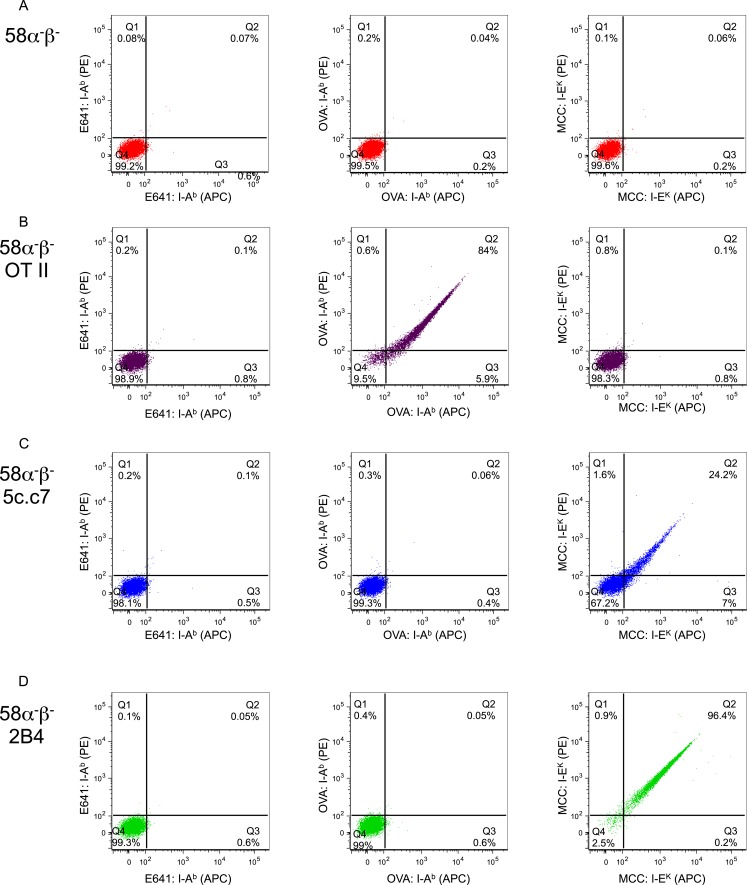
Tetramer validation on T-cell hybridomas.Dot plots showing E641:I-Ab (left panel), OVA: I-Ab (middle panel), and MCC:I-Ek (right panel) tetramer bound to (A) parental 58α−β− TCR-negative hybridomas or those transduced to express the (B) OT-II TCR specific for OVA: I-Ab, or the (C) 5c.c7 or (D) 2B4 TCRs specific for MCC:I-Ek. Each tetramer was made with streptavidin-PE and streptavidin-APC for two-color analysis as labeled on axis.